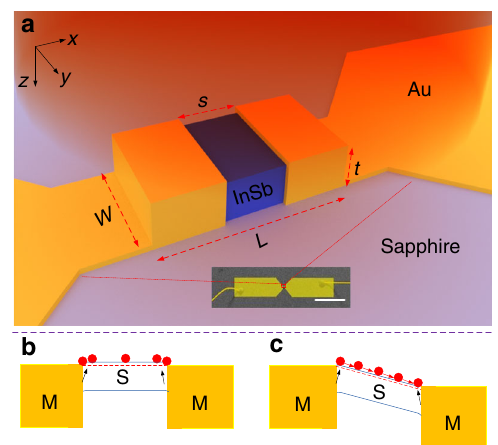
Fig. 1 Antenna-assisted subwavelength OMSM structure for millimeter and terahertz waves detection with gold and InSb as metal and semiconductor. a Schematic of the ohmic metal – semiconductor – metal (OMSM) structure in the center of the antenna-assisted OMSM structure (not drawn to scale). The wavelength of the incident photons λ is much longer than the length of the semiconductor L to meet the subwavelength requirement. s is the spacing between the edges of the two ohmic contacts. W and t are the width and thickness of the semiconductor layer, respectively. The inset is a false-colored SEM image of the fabricated device, a planar Au dipole antenna. The scale bar is 1 mm. b Zero bias case: symmetry prevents a photocurrent. c Biased case: The unidirectional movement of non- equilibrium electrons forms the photocurrent. M and S in b and c represent metal and semiconductor,